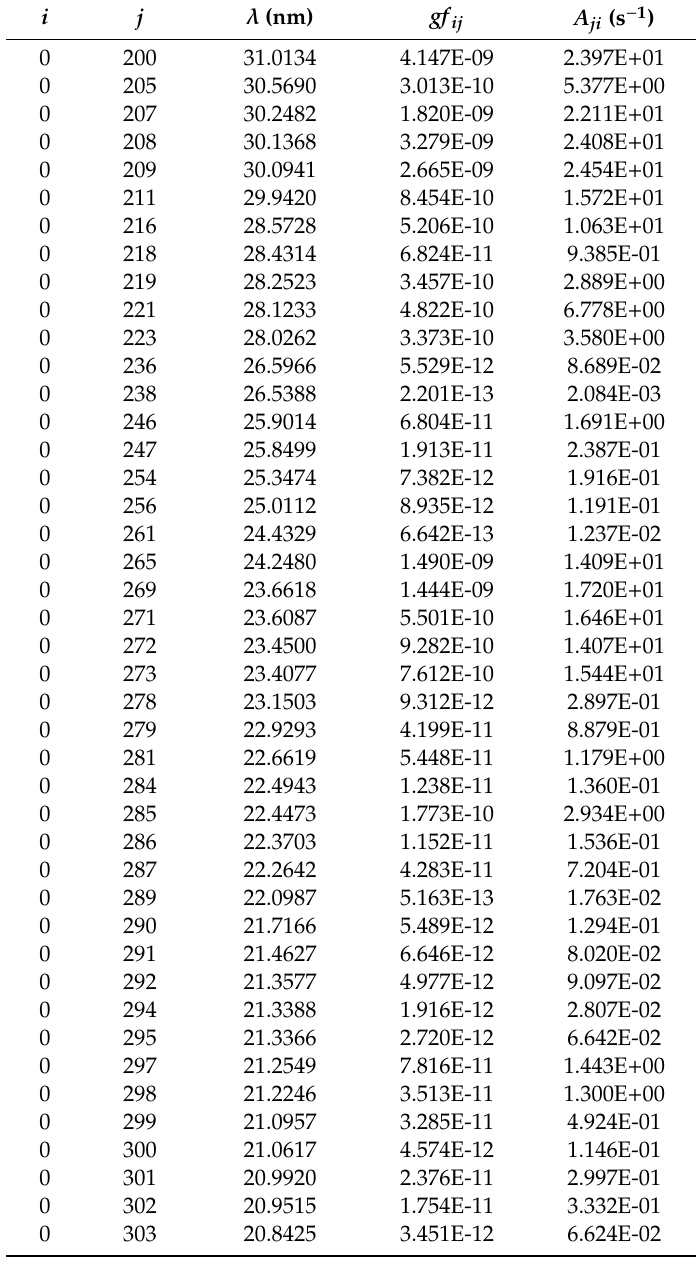
Table 5. Oscillator strengths gf ij , vacuum wavelengths λ (in nm), and transition probabilities A ji (in s − 1 ) for magnetic quadrupole (M2) transitions from the ground state in Eu-like